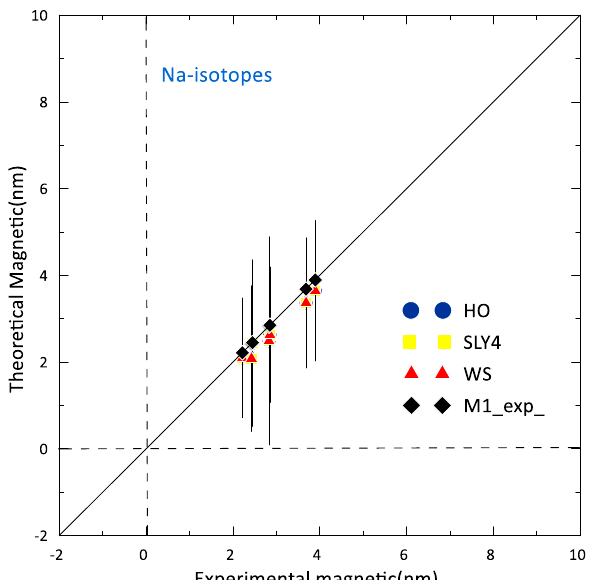
Figure 4: The calculated magnetic dipole moments μ (nm) vs the experimental data [16, 17] for Na-isotopes using different single-particle potentials; HO, WS, and SLy4.